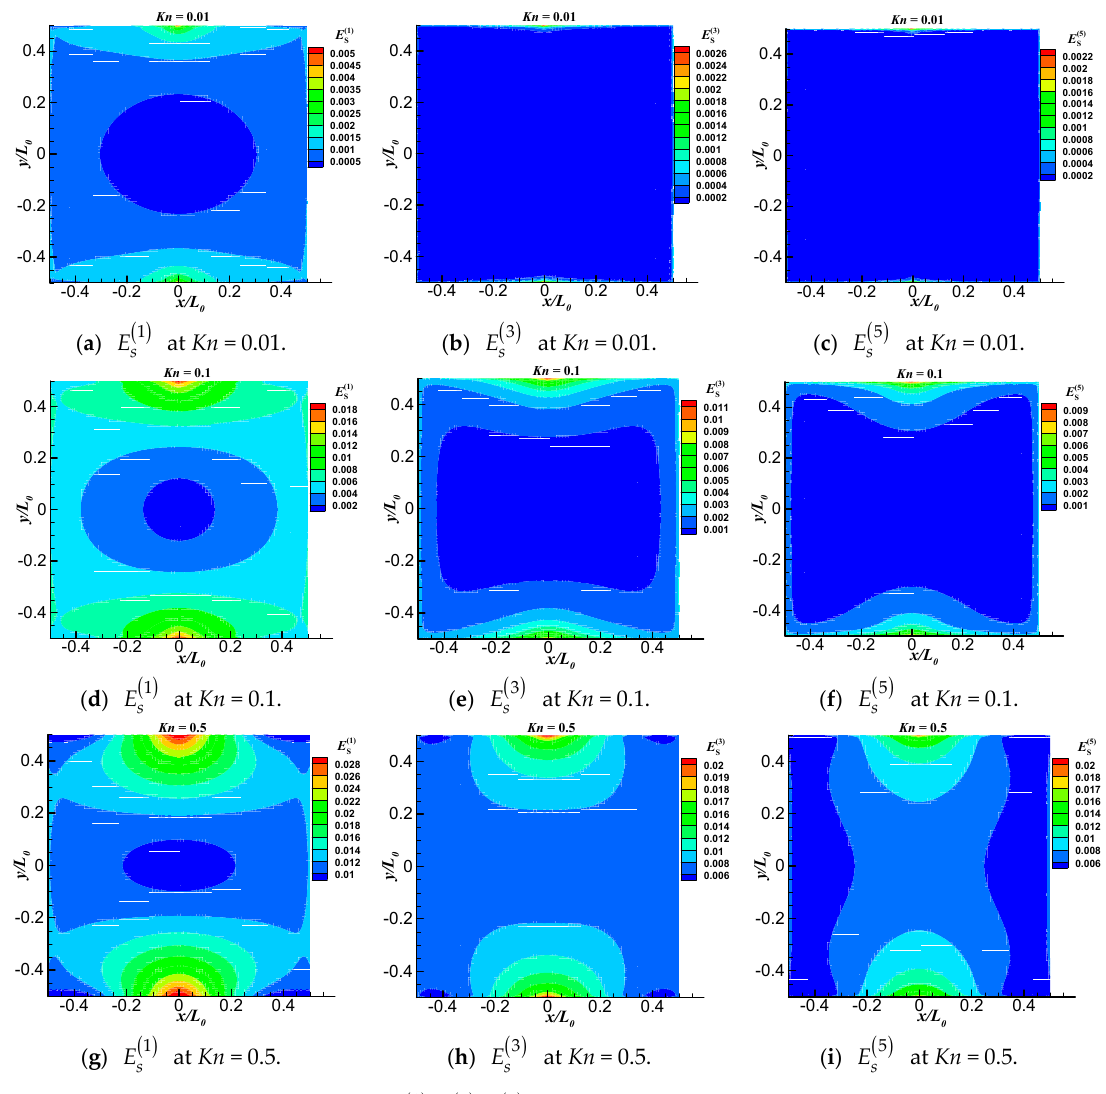
( 1 ) ( 3 ) ( 5 ) s , E s , E s at ( a – c ) Kn